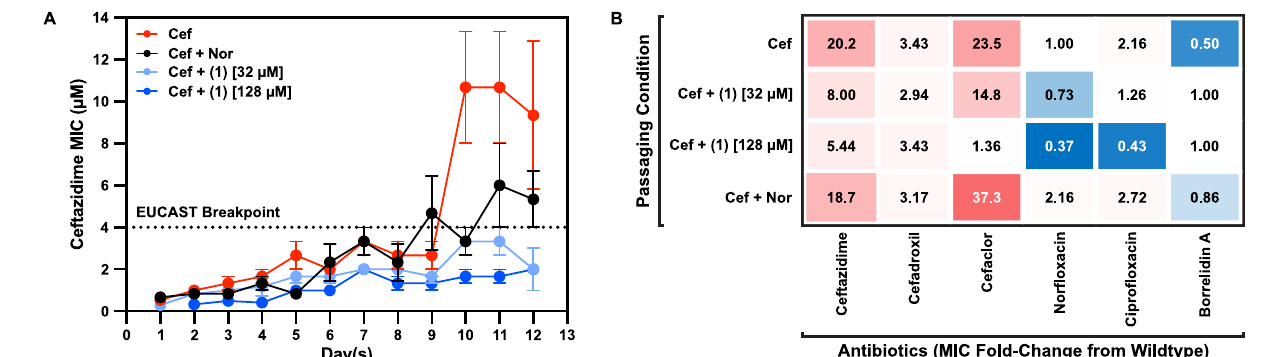
Fig. 5 | Sublethal doses of borrelidin A slow the emergence of cephalosporin resistance in wildtype E. coli . A Ceftazidime MIC values as determined through sequential passaging of wildtype E. coli MG1655 over twelve days under increasing ceftazidimedrugpressure,eitheralone(red;Cef),withanincreasingconcentration of nor fl oxacin(black;Nor),withaconstantconcentrationof 1 at32 µ M (lightblue), orwithaconstantconcentrationof 1 at128 µ M(blue).Populationsthatreached50% growth under the highest concentration of ceftazidime for each treatment condi- tionwereused toinoculate the following day ’ s cultures.Dottedline representsthe